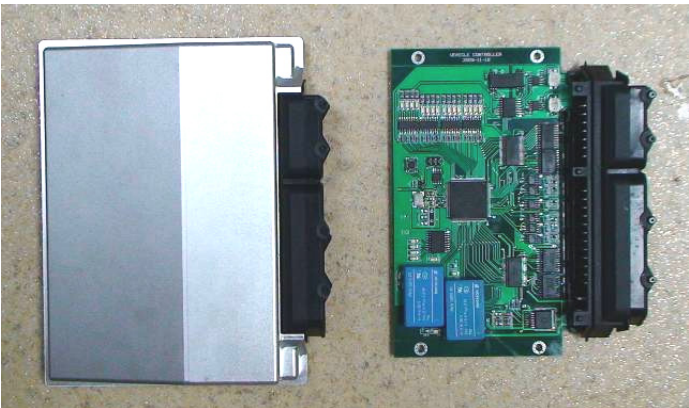
Figure 16. Vehicle controller